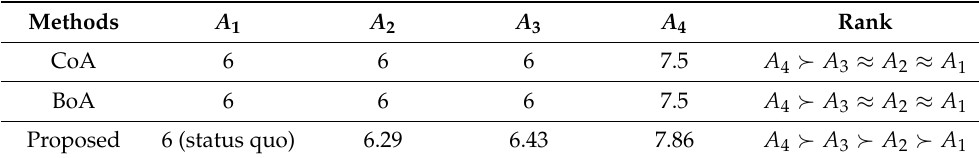
Table 3. The comparison of defuzzifying approaches in Example 1.